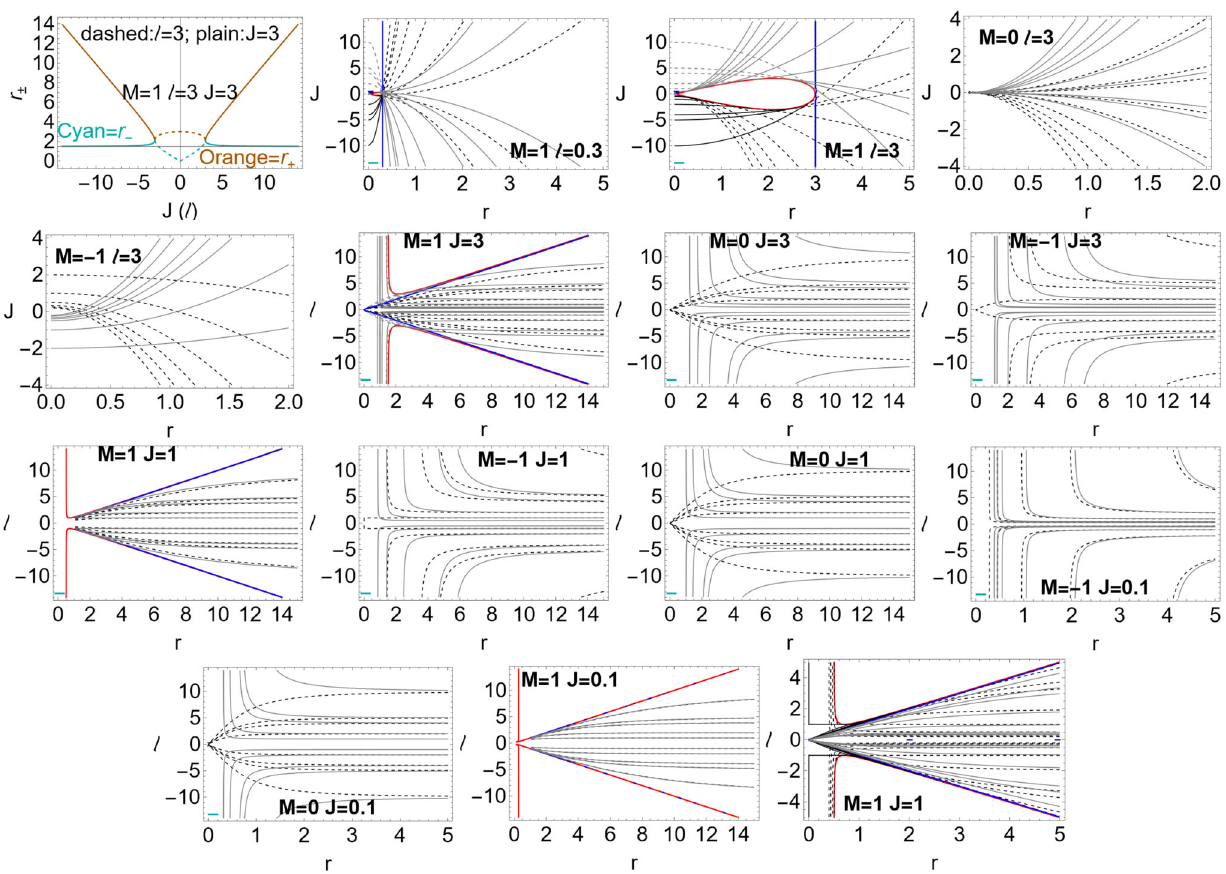
Fig. 16 Metric bundles of the BTZ geometry of Eq. (50). Dashed curves are for light-like orbital frequencies ω − = constant and plain curves are for ω + = constant. Upper left panel: The horizons r ± as functions of the angular momentum J (dashed) and (cid:25) (plain), being related to the cosmological constant by Λ = − 1 /(cid:25) 2 , for selected values